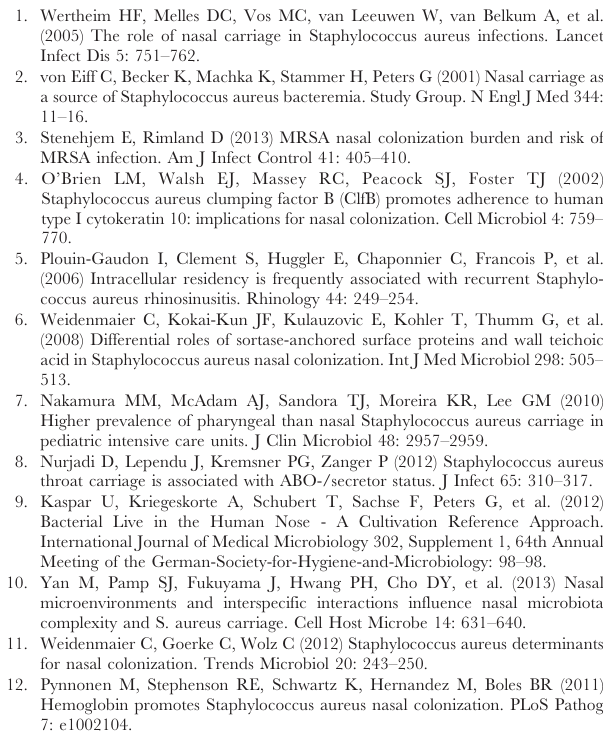
three ( P , 0.001) asterisks ( * ). Figure S6 Confocal microscopy of S. aureus adhesion to CRNECs. Green fluorescent S. aureus (FITC labeled) wild-type (A) and tagO mutant (B) cells where allowed to adhere to cotton rat nasal epithelial cells (CRNECs) under mild shear stress condition (0.5 dynes) in ibidi-chamber slides. Cells were stained with DAPI and phalloidin-TRITC. Bars represent 20 m m. Figure S7 Amino acid sequence of SREC-I with putative WTA binding site. Negatively charged amino acids are labeled in red, positively charged amino acids in yellow (A). Model of WTA-SREC-I interaction. Both the zwitterionic charge of the